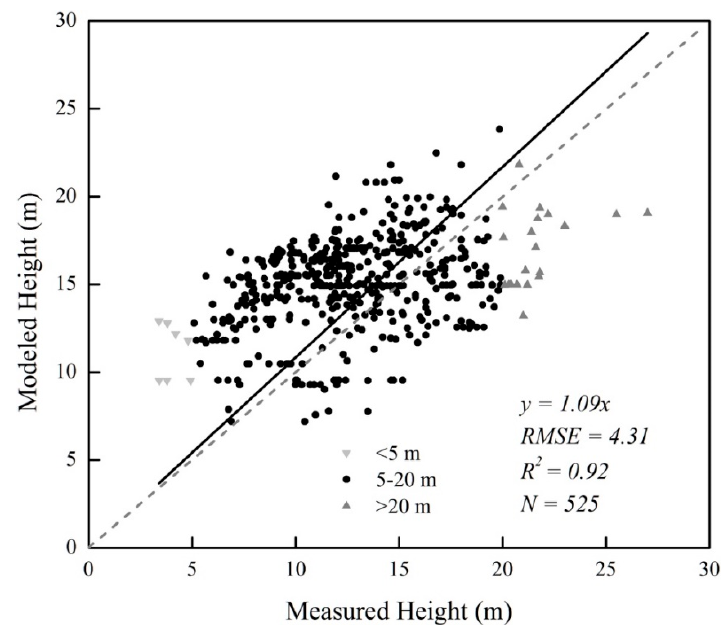
Figure 6. Comparison of heights modeled using multiple sources of remotely sensed data and heights measured in the field. Down triangles and up triangles indicate field measured heights less than 5 m and greater than 20 m, respectively, the dotted line is 1:1 line.